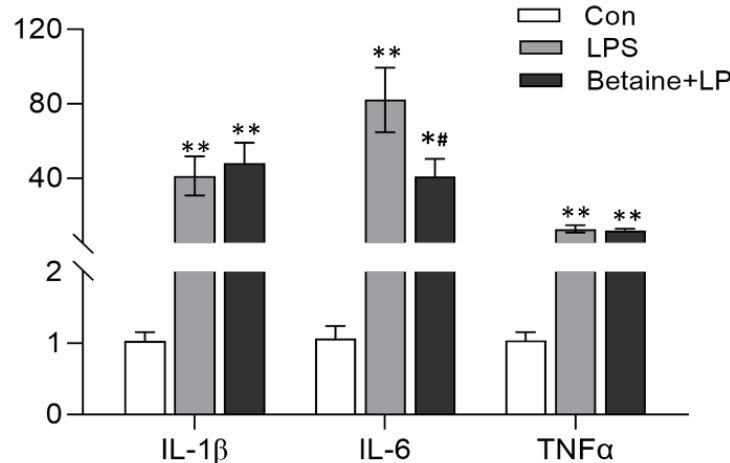
Figure 1. qRT-PCR quantification of the mRNA expressions of pro-inflammatory cytokines. Newly hatched broilers were provided with water supplemented with betaine at a dose of 1000 mg/L. At the age of two weeks, the broilers were intraperitoneally injected with LPS at a dose of 1 mg/kg BW. Two hours after the LPS treatment, leg muscle was collected, and the relative mRNA expressions of IL-1 β , IL-6, and TNF α were determined using qRT-PCR. The treatment and method are the same for Figures 2 and 3. Values are mean ± SEM, n = 6/group. Significance levels: * p < 0.05, ** p < 0.01 vs. control, # p < 0.05 vs. LPS.